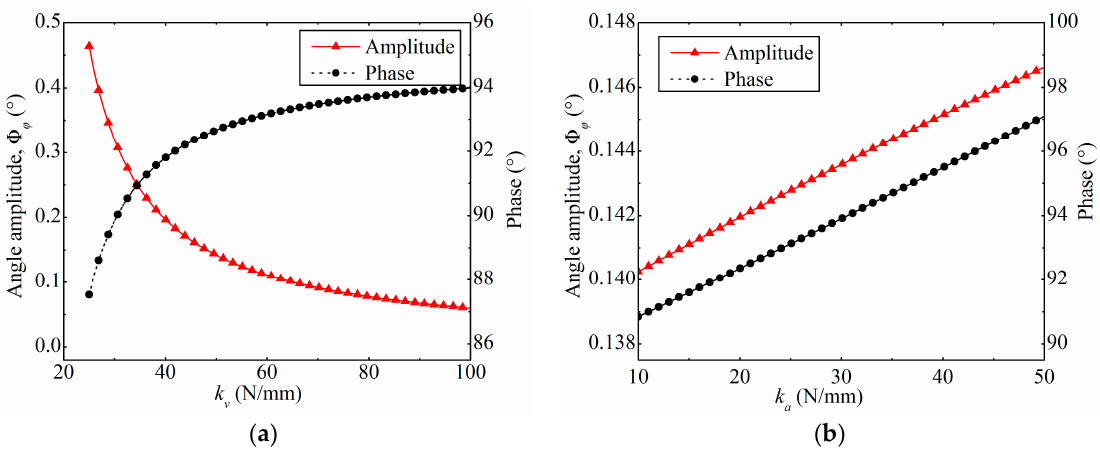
Figure 9. The influence of the springs. ( a ) Stiffness of the control valve spring ( k v ) and ( b ) stiffness of the swash plate spring ( k a